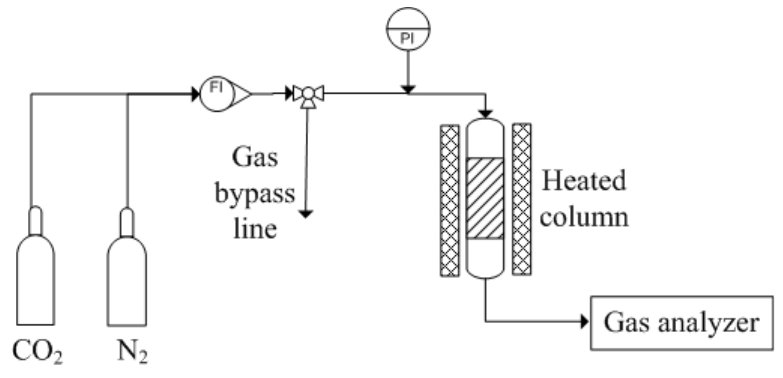
Figure 11. Schematic diagram of experiment